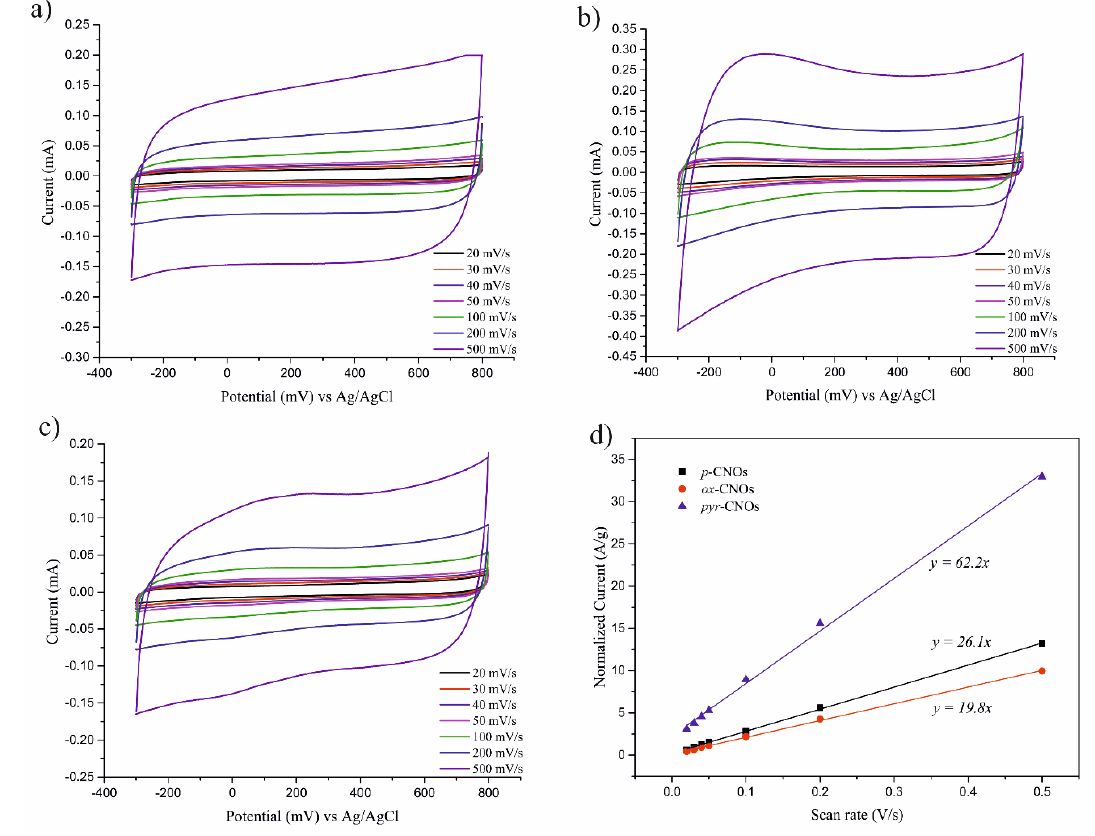
Figure 9. Dependence of the CV curves on the scan rate in the ( a ) p -CNOs, ( b ) ox -CNOs, and ( c ) pyr -CNOs. ( d ) Linear regression of the current density against the scan rate. Table 3. Specific capacitance values obtained for the CNO materials.